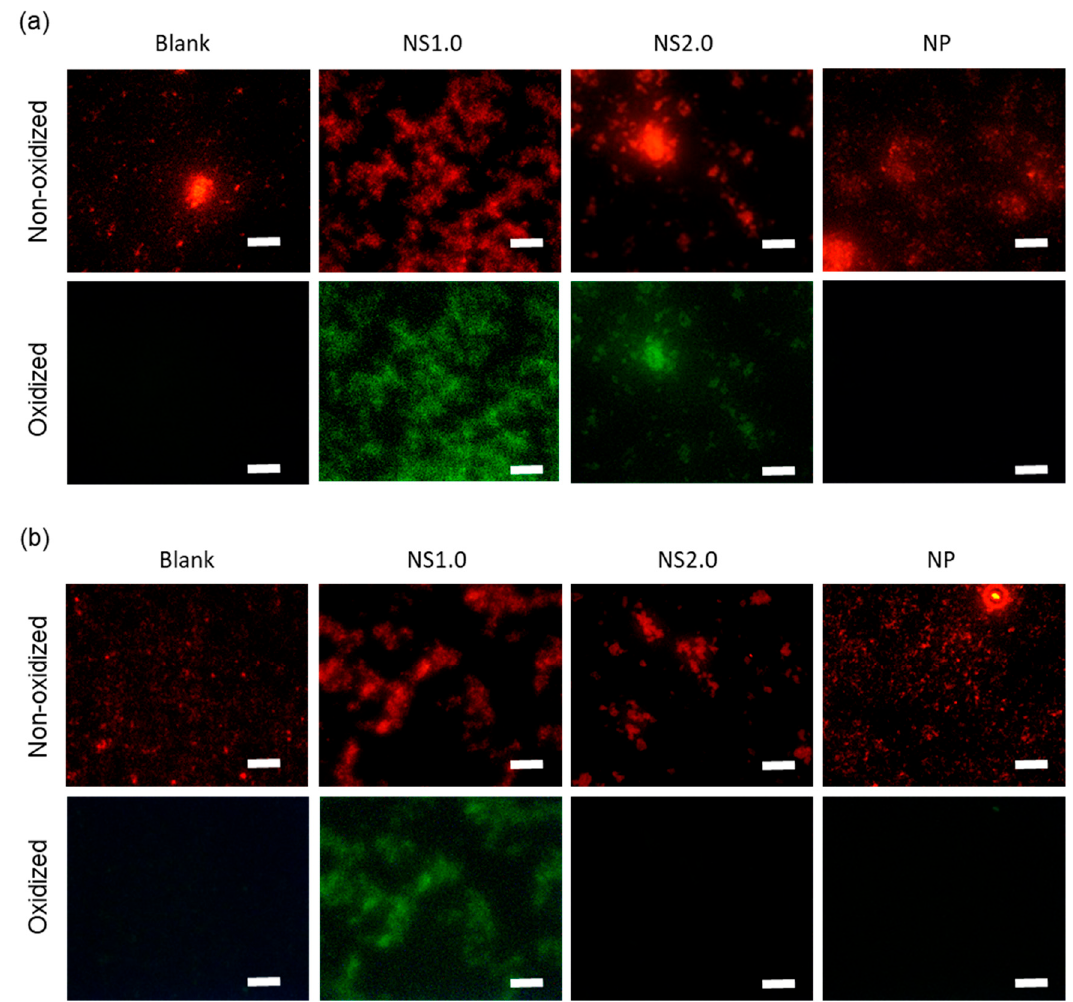
Figure 5. Lipid peroxidation of S. mutans loaded with C11-BODIPY581/591 in the presence ( a ) and absence ( b ) of UV irradiation conditions. Upper panel: non-oxidized image. Lower panel: oxidized image. Scale bar: 250 μ m.